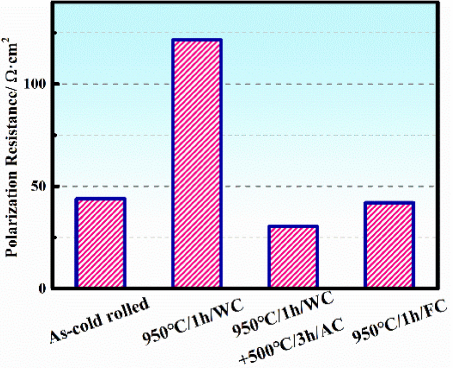
Figure 7. Variations of R pol as a function of heat treatment